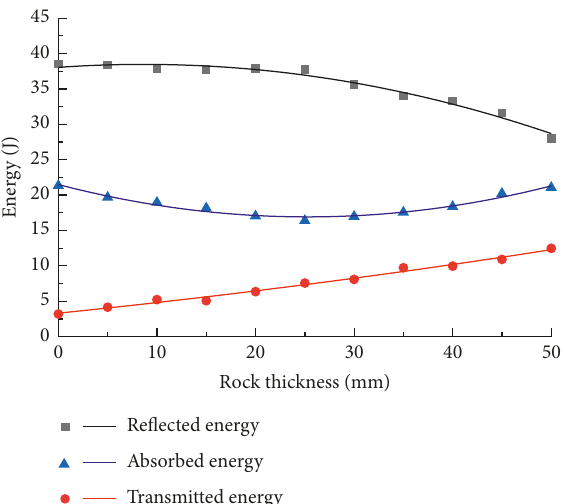
Figure 9: Curve of relation between rock thickness and reflected energy, absorbed energy, and transmitted energy.